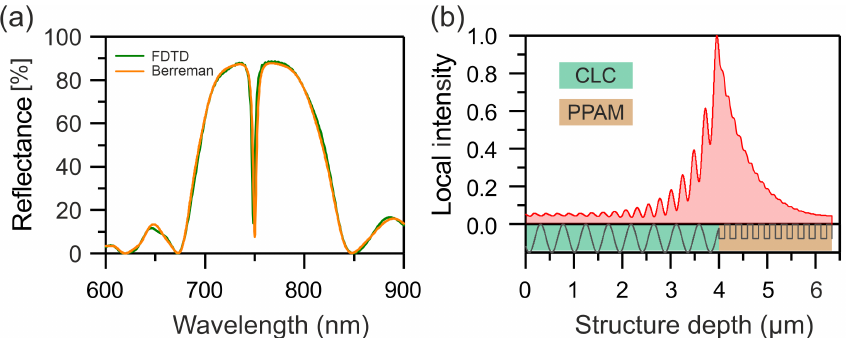
Figure 1. ( a ) Reflection spectra of the CLC–PPAM structure calculated by the Berreman (orange line) and FDTD (green line) methods. ( b ) Local field intensity distribution in the CLC–PPAM structure at the COTS wavelength.